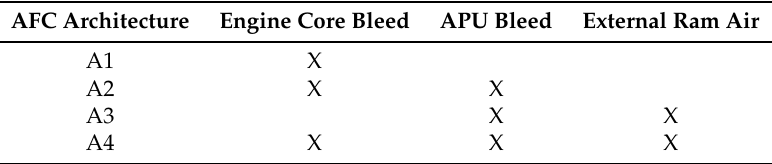
Table 2. Summary of supply sources for HLAFC architectures considered in this